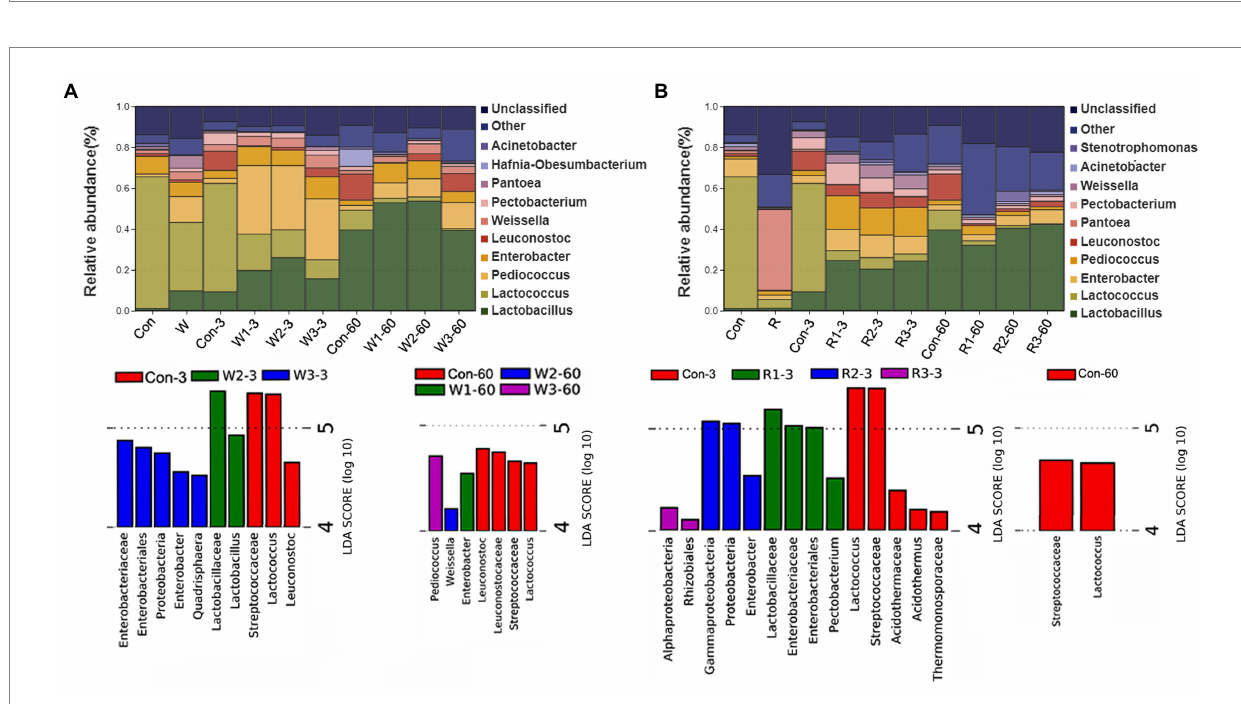
FIGURE 5 Microbial community composition and Lefse of bacteriome during the anaerobic fermentation of Chinese cabbage waste. The control group (Con). Chinese cabbage waste was mixed with (A) wheat bran at a mass ratio of 383:117 (W1), 353:147 (W2), and 323:177 (W3) or with (B) rice bran at 387:113 (R1), 358:142 (R2), and 329:171 (R3), respectively; 3 and 60 mean day 3 and day 60,